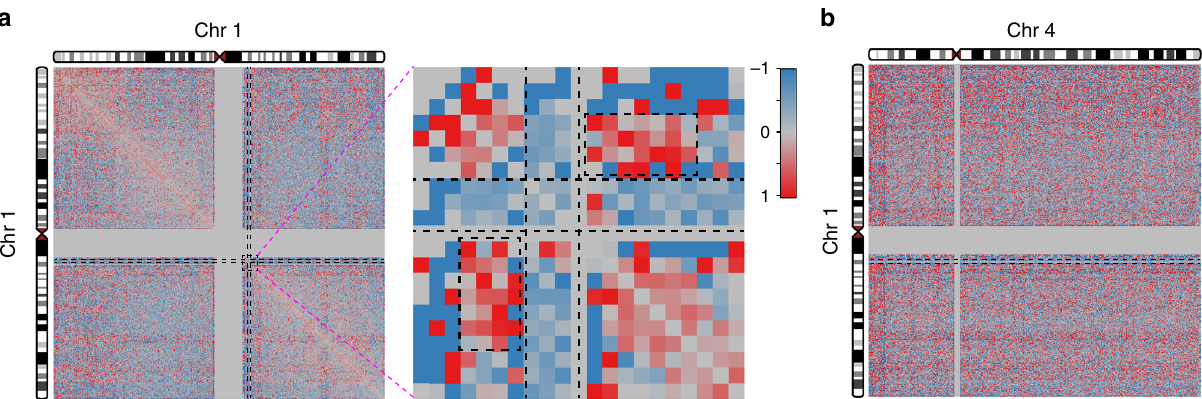
Fig. 8 Effect of the large deletion CNV on 1q21.1 on chromosome conformation. a Fold change of cis -contacts of chromosome 1 in 1q21.1del ( n = 2) versus control ( n = 6) cell lines. Black boxes mark the regions of increased contacts between the proximal and distal fl anking regions of the 1q21.1 deletion. b Fold change of trans -contacts between chromosome 1 and 4 in 1q21.1del ( n = 2) versus control ( n = 6) cell lines. In a , b , black dashed lines mark the boundaries of the 1q21.1 deletion. Each cell in the heatmap represents the chromosomal contact level between two 500 kbp regions. The color scale goes from − 1 (blue) to 0 (gray) to